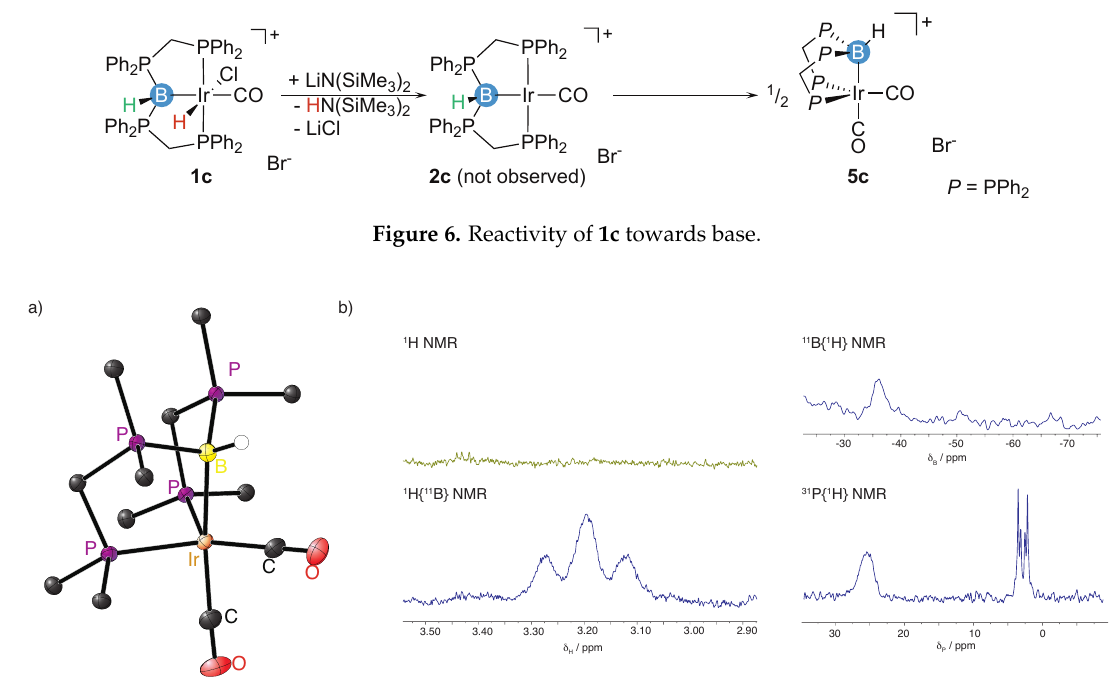
Figure 7. ( a ) Molecular structure of the cationic complex in 5c in the solid state (ellipsoids are drawn at 50% probability level; carbon atoms of the phenyl rings, carbon-bound hydrogen atoms, co-crystallized solvent molecules and counter ion are omitted for clarity); ( b ) Selected NMR spectra of complex 5c